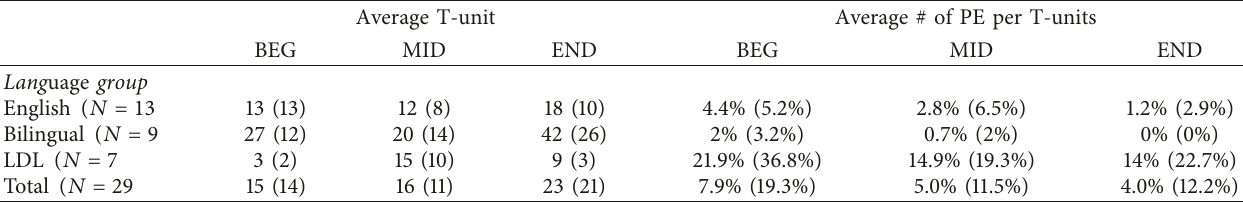
Table 4: Means and standard deviations for average T-units per sample and phrasal errors (PEs) as a percentage of T-unit for the beginning, middle, and end of the year writing samples by language groups.